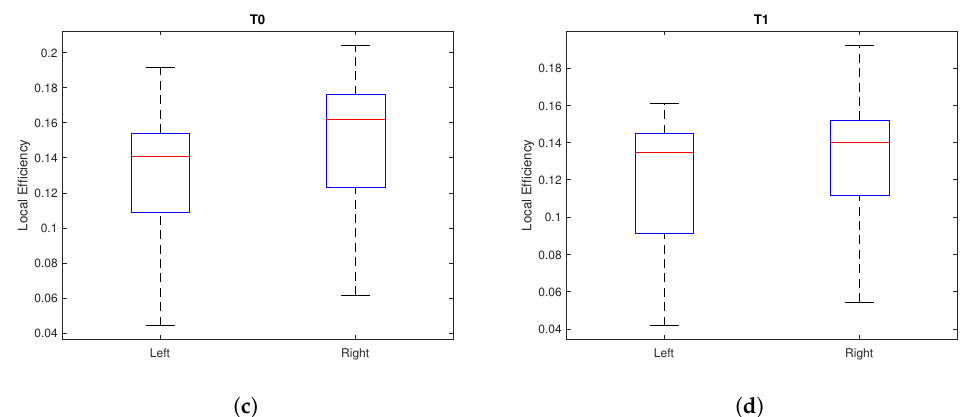
Figure 4. Repetition task: boxplot of global efficiency for each hemisphere at time ( a ) T0 and ( b ) T1; boxplot of local efficiency for each hemisphere at time ( c ) T0 and ( d ) T1. On each box, the bottom and the top edges denote the 25th and 75th percentiles, respectively; the line inside the box indicates the median; the “whiskers” extend below and above the box up to the minimum and maximum data values, respectively. The ‘+’ marker symbol outside the whiskers represents the outliers.